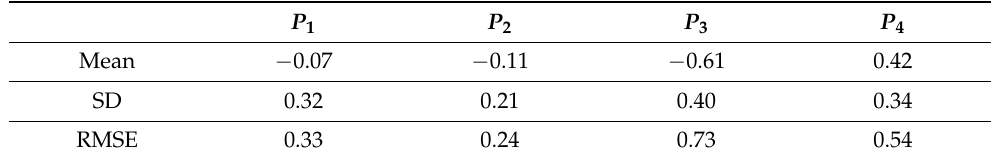
Figure 5. The displacement time series obtained by the proposed method for the four reflectors P 1 , P 2 , P 3 , and P 4 respectively in ( a – d ). The blue line is the original observed displacement data, the red line is the atmospheric delay, the yellow line is the displacement fitting line, and the dark line represents the difference between the original observed displacement data and the atmospheric delay. Table 1. The mean value, SD, and RMSE of the time series of the four reflectors. (All values in the table are expressed in